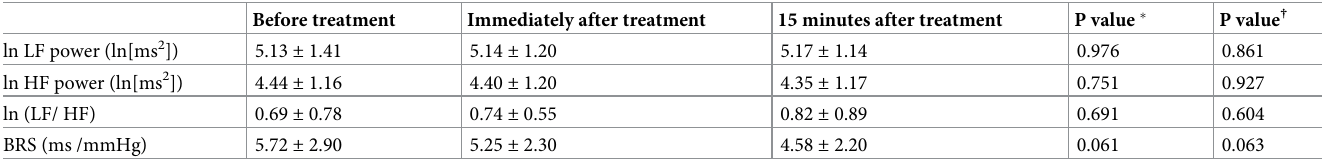
Table 1. Changes in the heart rate variability and baroreceptor reflex sensitivity. Before treatment Immediately after